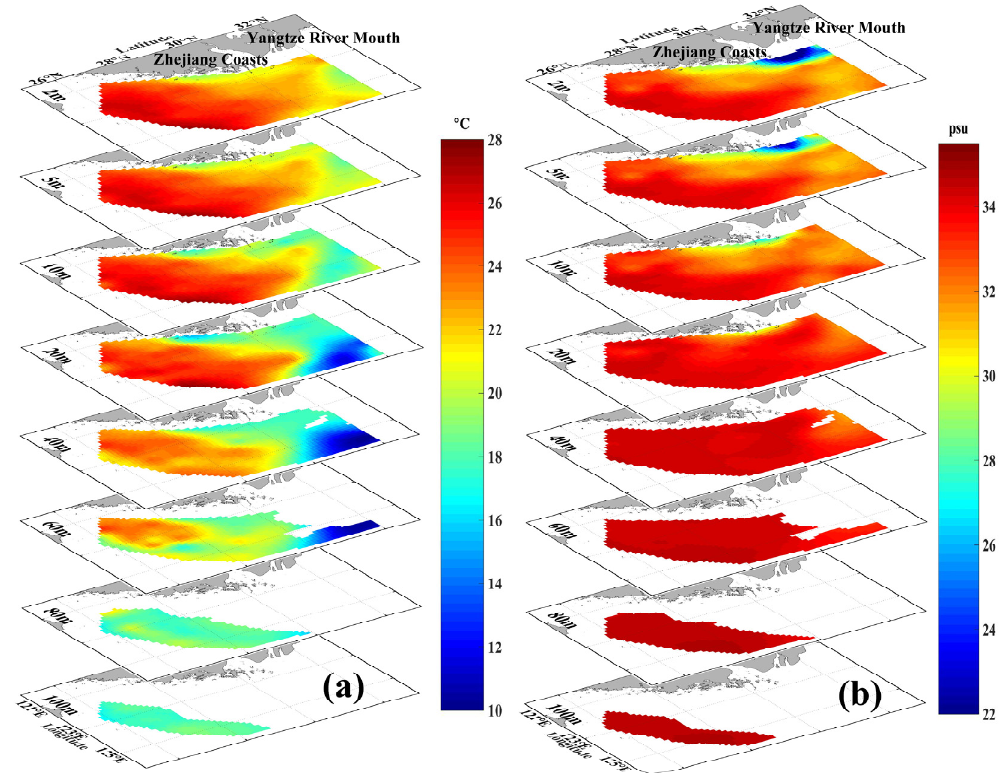
Figure 11. The 3D reconstruction of the in situ observations in summer 2011. ( a ) Temperature; ( b ) Salinity.